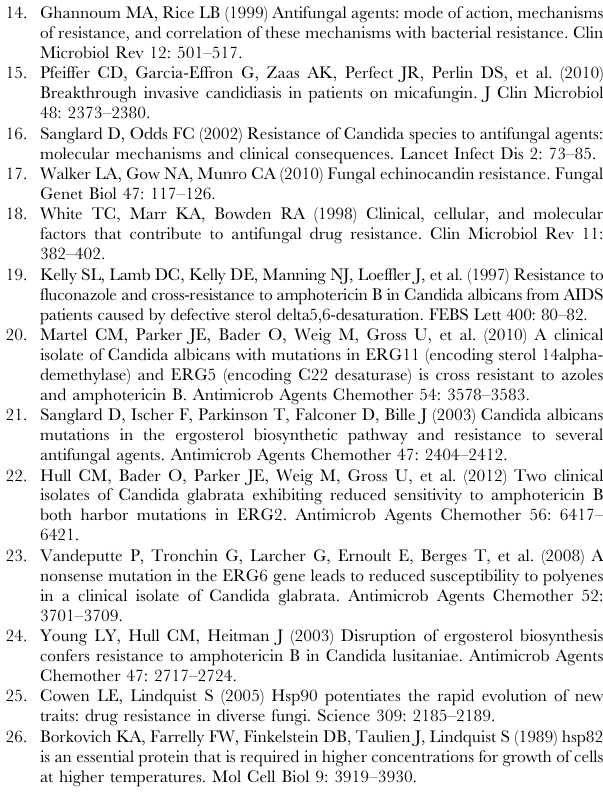
assembly of the C. tropicalis genome requires the use of smaller sequence contigs. Figure S3 Heterozygosity analysis of in vitro –evolved series. (A) Whole-genome analysis of loss of heterozygosity events across four sequenced isolates from in vitro –evolved series (from Figure 1B). A list of all SNP positions in the four strains was compiled and then analyzed for heterozygosity by base ratio (see Materials and Methods). Sites homozygous for the reference base are depicted in blue, homozygous for the variant base in red, and heterozygous in white. The loss of heterozygosity is focused on the left arm of chromosome 3, which contains ERG6. (B) Heterozy- gosity analysis of chromosome 3 demonstrates loss of heterozy- gosity in isolate # 4. Sliding-window analysis of base ratio along chromosome 3 depicts loss of heterozygosity in the left arm of chromosome 3. Figure S4 Minimal inhibitory concentrations of Hsp90 inhibitors and cytotoxic compounds. (A) Sensitivity of AmB- resistant mutants to diverse cytotoxic compounds. MIC80 of each strain against each compound was determined by microplate dilution assay in YPD at 30 u C. (B) MIC80 of strains to four Hsp90 inhibitors in YPD at 30 u C. (C) Fold sensitization, relative to wild- type, of mutant strains to cytotoxic agents and Hsp90 inhibitors (Hsp90 inhibitors highlighted in red for clarity). Table indicates the value obtained when the MIC80 for each compound in the wild-type strain is divided by the MIC80 for that compound in that mutant strain.